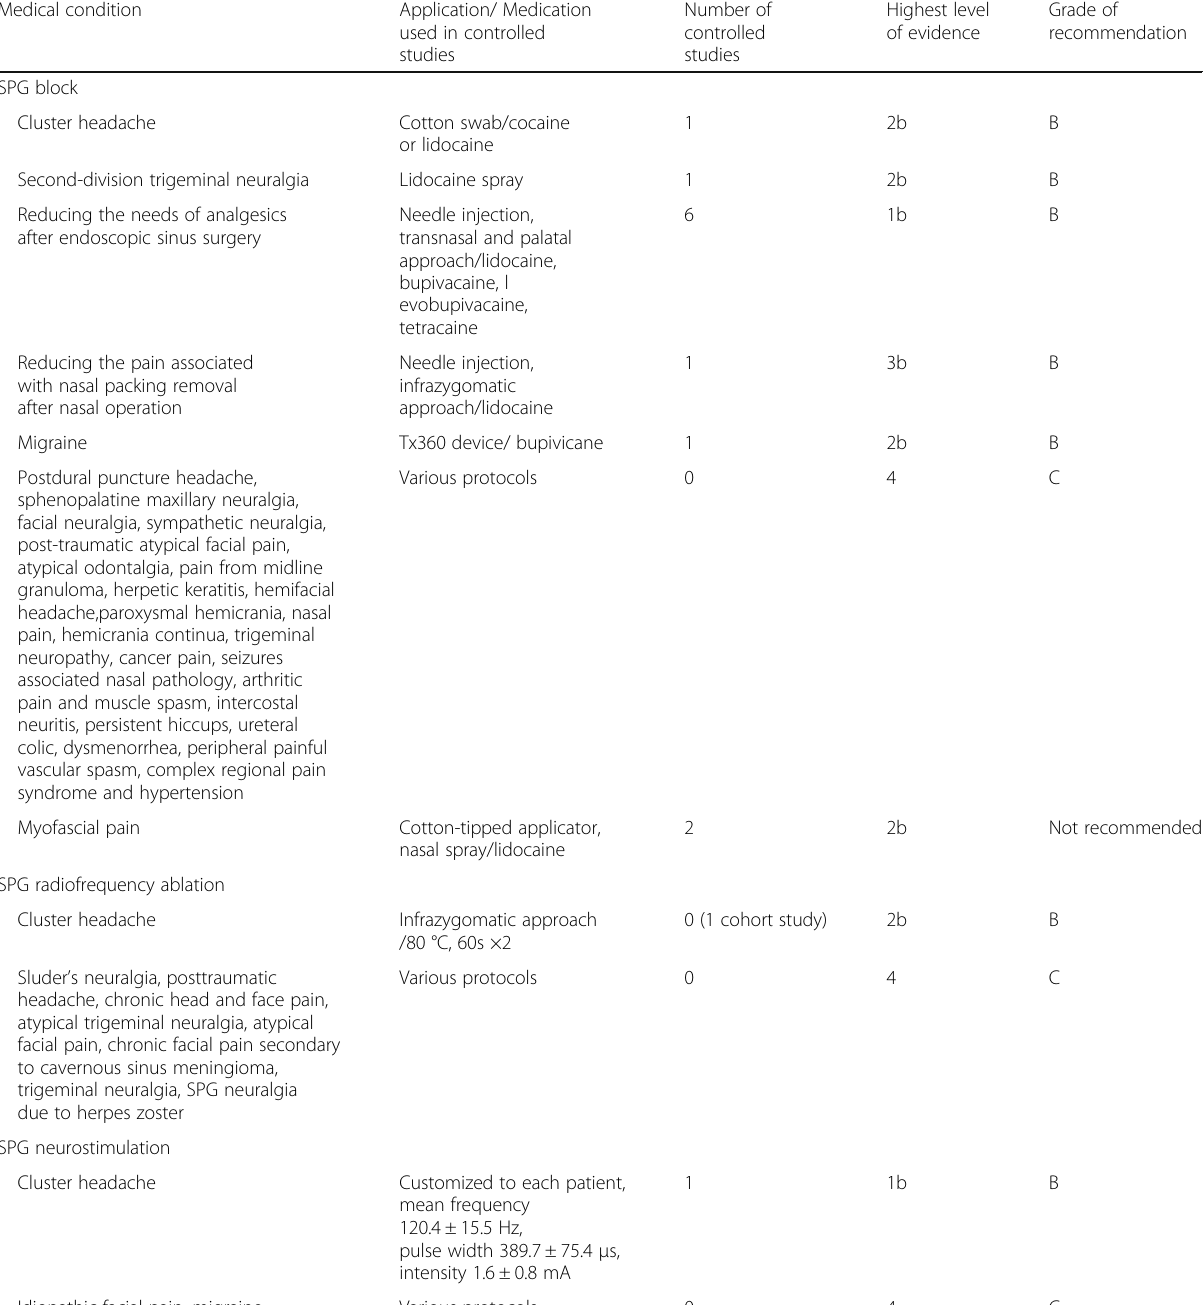
Table 1 Summary of evidence level and grade of recommendation for SPG block, radiofrequency ablation and neurostimulation Medical